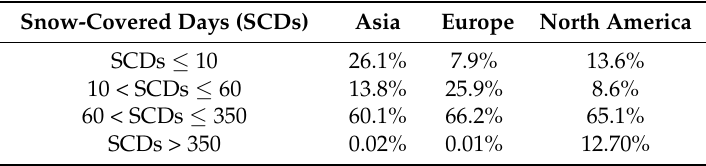
Table 2. Percentage of different snow-covered days by area in Asia, Europe and North